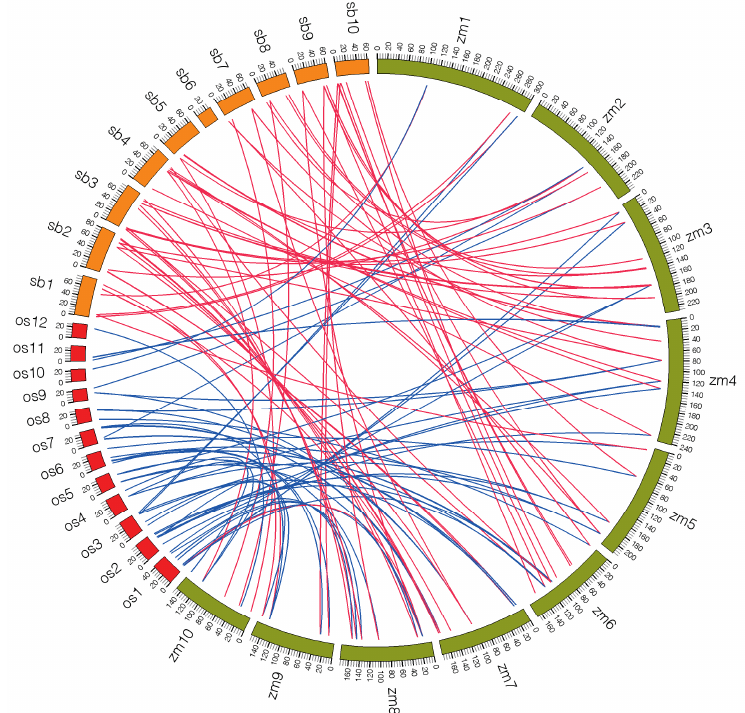
Figure 5. Microsynteny of PHD regions across maize, sorghum and rice. The maize, sorghum and rice chromosomes are shown in different color boxes and labeled zm, sb and os, respectively. Numbers along each chromosome box indicate sequence lengths in megabases. Red lines represent the syntenic relationships between maize and sorghum PHD regions, and blue lines represent the syntenic relationships between maize and rice